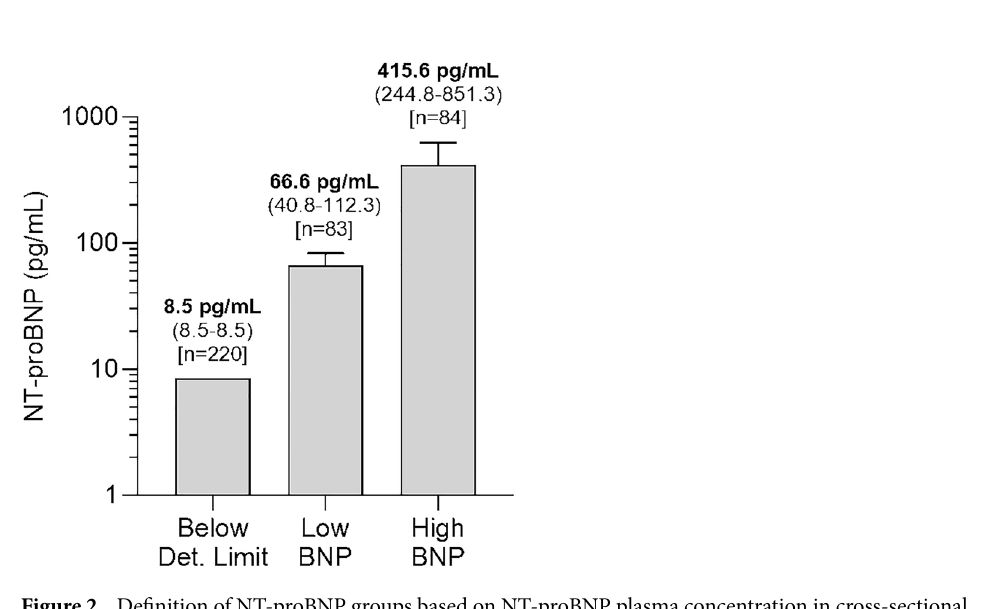
Figure 2. Definition of NT-proBNP groups based on NT-proBNP plasma concentration in cross-sectional analysis. Due to the skewed distribution of NT-proBNP values in the cross-sectional FoCus cohort, we created three groups representing (1) NT-proBNP concentration below detection limit of 25.4 pg/mL (n = 220, left bar) as well as (2) low and (3) high NT-proBNP concentration. The latter two groups were created based on the median (158.9 pg/mL) of all detectable values. Individuals with an NT-proBNP concentration above 25.4 pg/ mL but below 158.9 pg/mL were assigned to the low NT-proBNP group (n = 83, middle bar), while individuals with an NT-proBNP concentration equal or above 158.9 pg/mL were assigned to the high NT-proBNP group (n = 84, right bar). Bars denote median NT-proBNP concentration and error bars denote 95% CI of the median. Y axis is formatted in log 10 to account for skewed distribution of NT-proBNP values. CI; confidence interval; NT-proBNP, N-terminal pro brain natriuretic